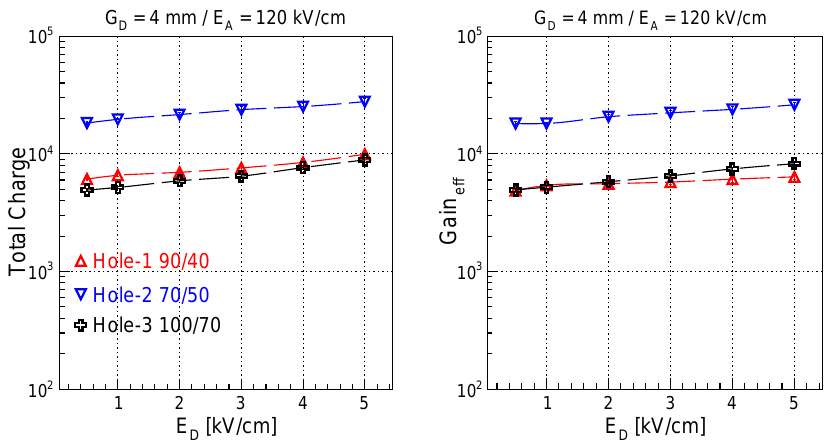
Figure 6. Total charge ( left ) and effective gain ( right ) vs. E D . Hole-2 configuration leads to higher gains.